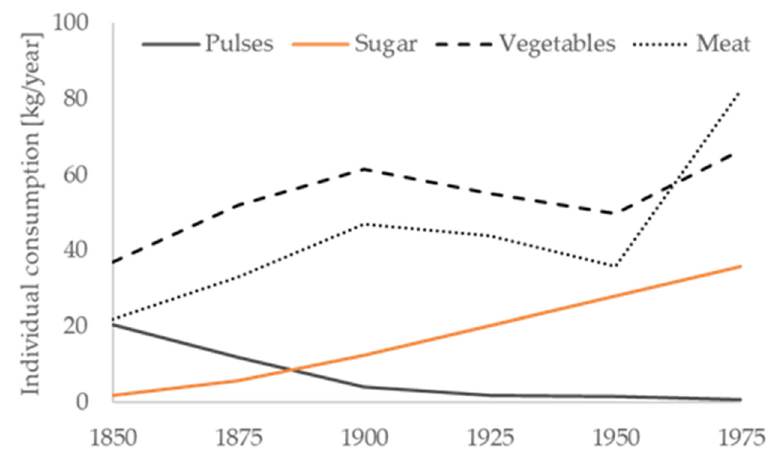
Figure 2. Nutrition transition in Germany, with special emphasis on pulses, refined sugar, vegetables and meat. Data on food consumption are adopted from Teuteberg (1979) and meat. Data on food consumption are adopted from Teuteberg (1979) [49].